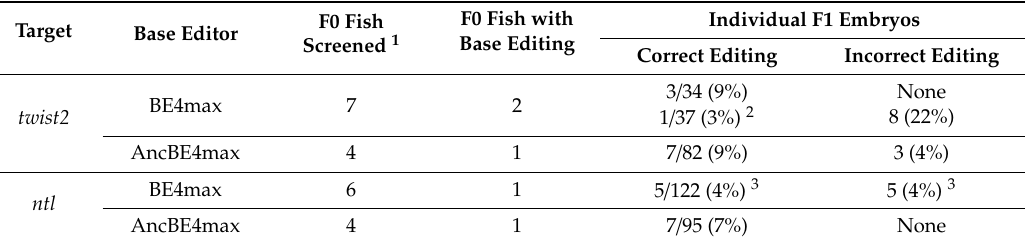
Table 3. Details of screening for germline